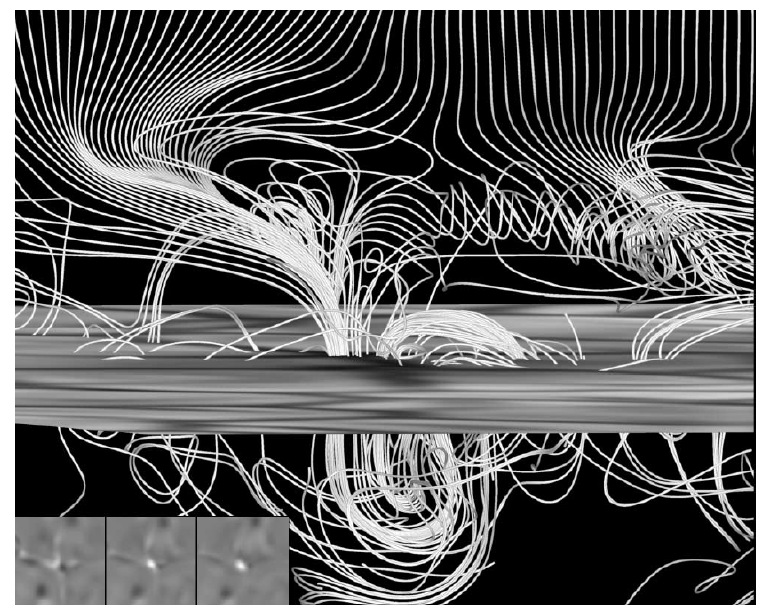
Figure 32: Field line rendering from a magnetoconvection simulation by Abbett (2007). The rendering shows collections of field lines that poke through the surface as granular-scale Ω-loops as well as some U-loops that are trapped by downflow lanes. Image reproduced with permission, copyright by